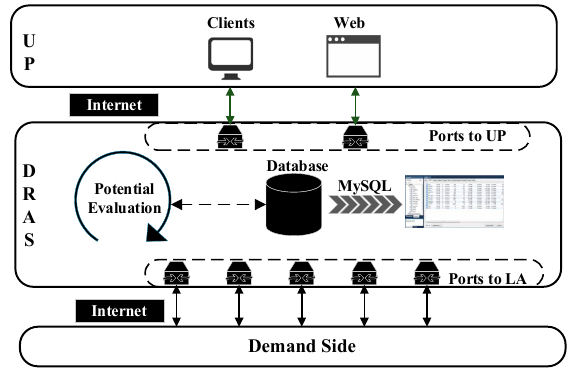
Figure 2. The architecture of the grid side.